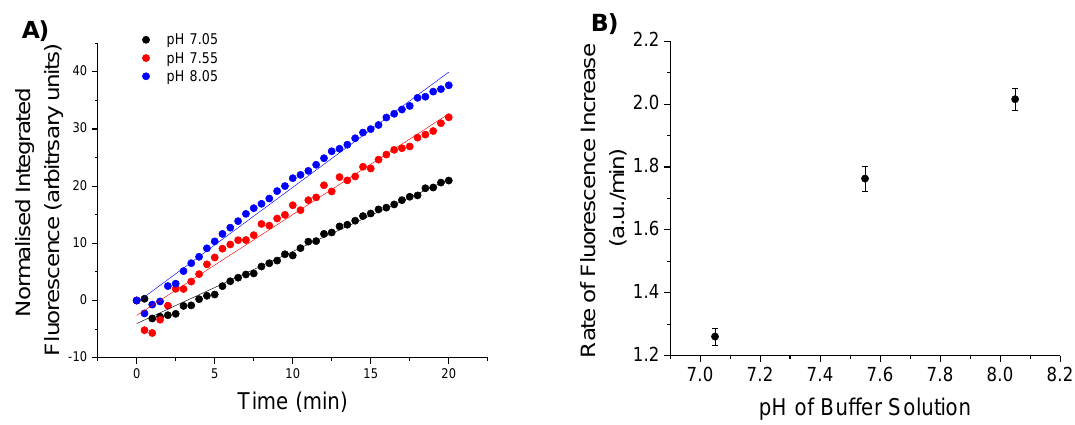
Figure 4. Response of CPF1 to 100 µ M H 2 O 2 in solutions that varied in pH. ( A ) Integrated fluorescent responses of probes to 100 µ M H 2 O 2 in pH 7.05, 7.55 and 8.05 over 20 min using blue excitation; ( B ) Rate of increase in fluorescence of each probe with H 2 O 2 in each of the 3 pH solutions. Error bars indicate the standard error of the calculated slope.